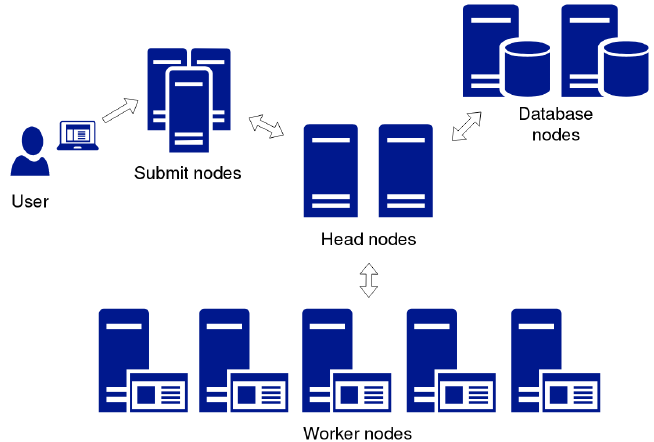
Figure 2: The SLURM cluster